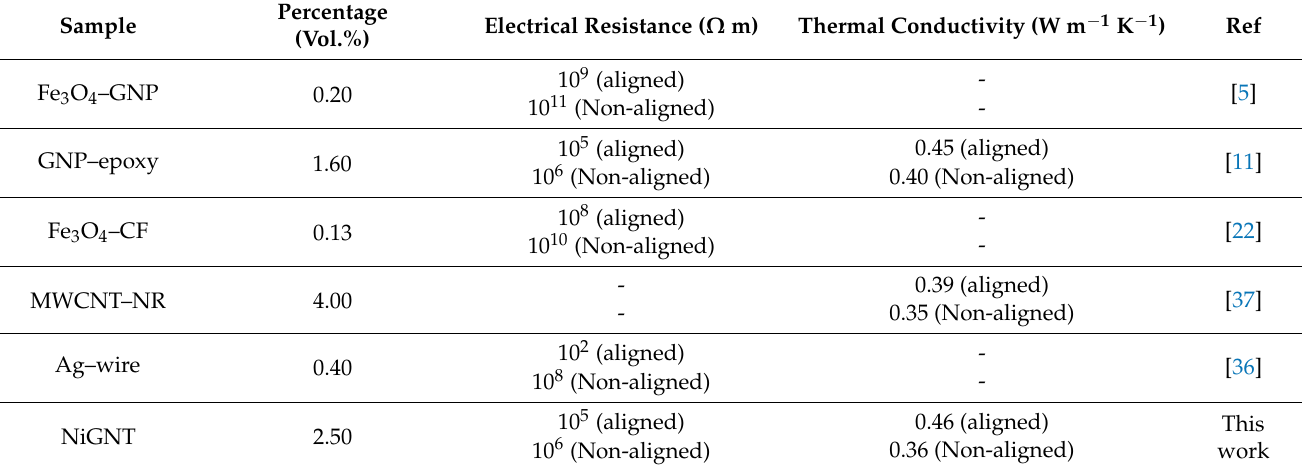
Table 3. Comparison of conduction performances between NiGNT–epoxy composites and results of previous